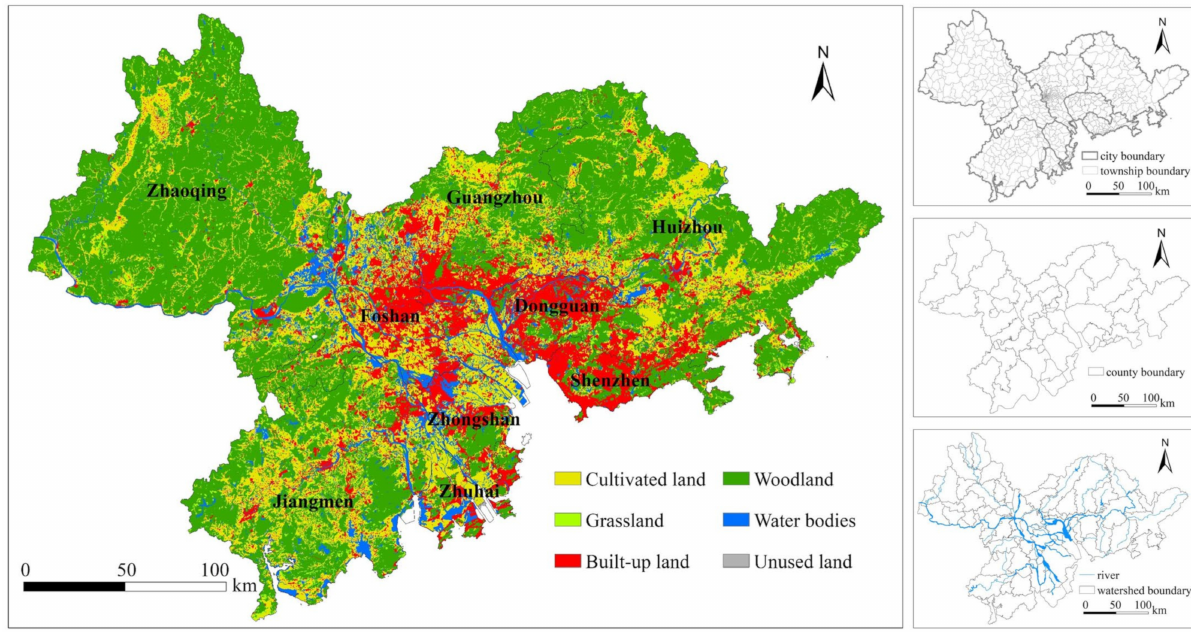
Figure 1. The spatial distribution of land use in 2015 and the boundaries of township, county, watershed, and city levels in the Pearl River